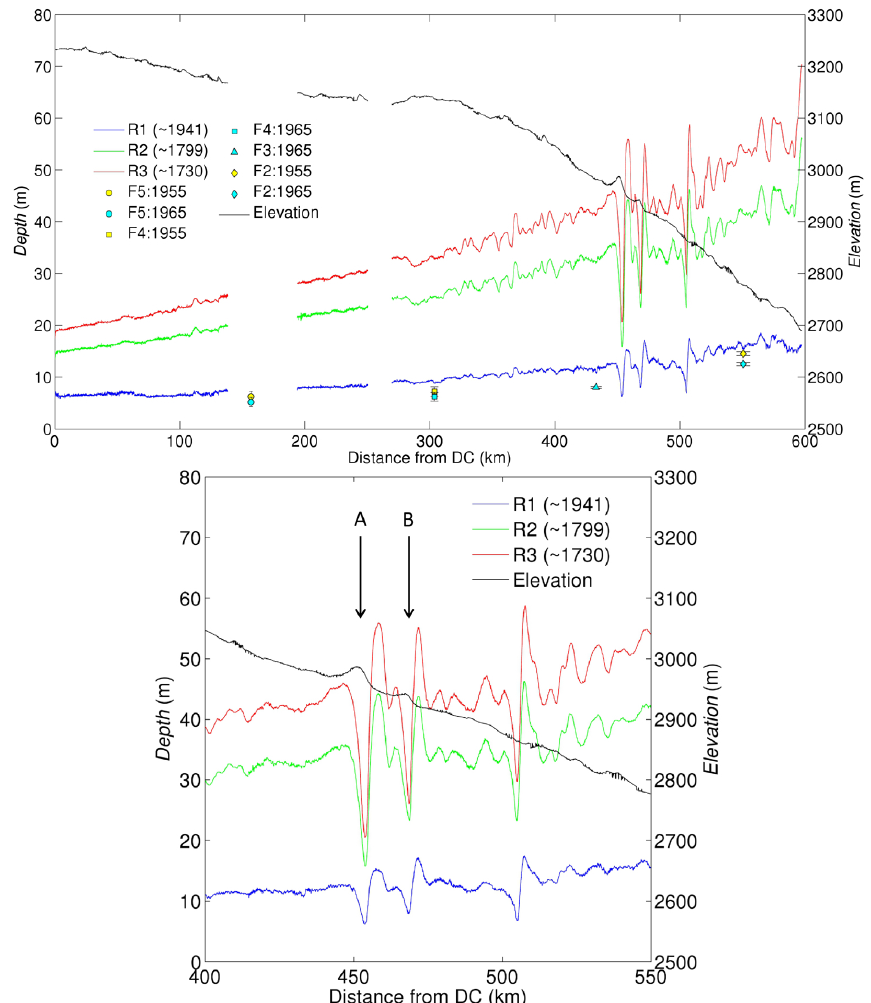
Fig. 6. Depth of reflectors and surface elevation vs. distance from DC. Couloured symbols represent depths of the 1955 and 1965 layers measured on the cores for the purpose of comparison, and their associated error bars. The lower panel focuses on undulations located between 400 and 550km from DC, with A and B refering to two local elevation peaks that link with undulations, as discussed in the text.